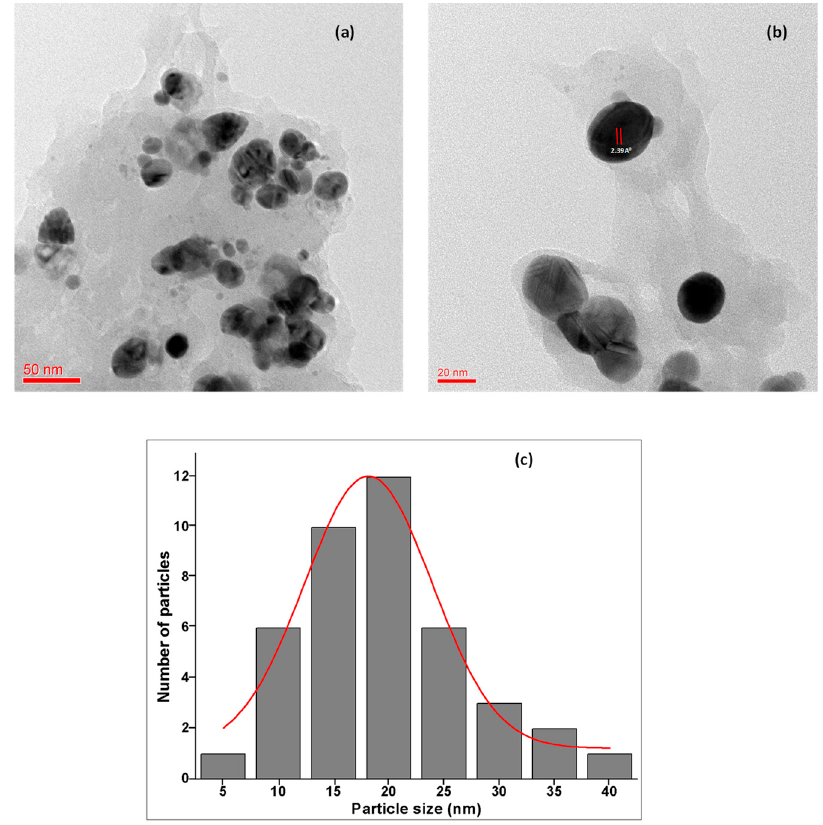
Figure 8. HR-TEM images of Ta-AgNPs: ( a ) at 50 nm; ( b ) at 20 nm amplification; and ( c ) average particle size histogram of the Ta-AgNPs produced under optimized conditions.